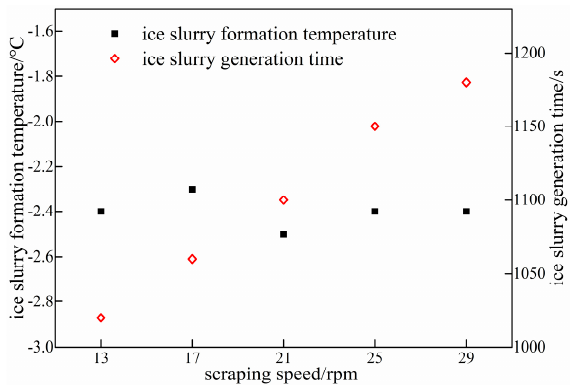
Figure 12. Ice slurry formation characteristics at different scraping speeds.